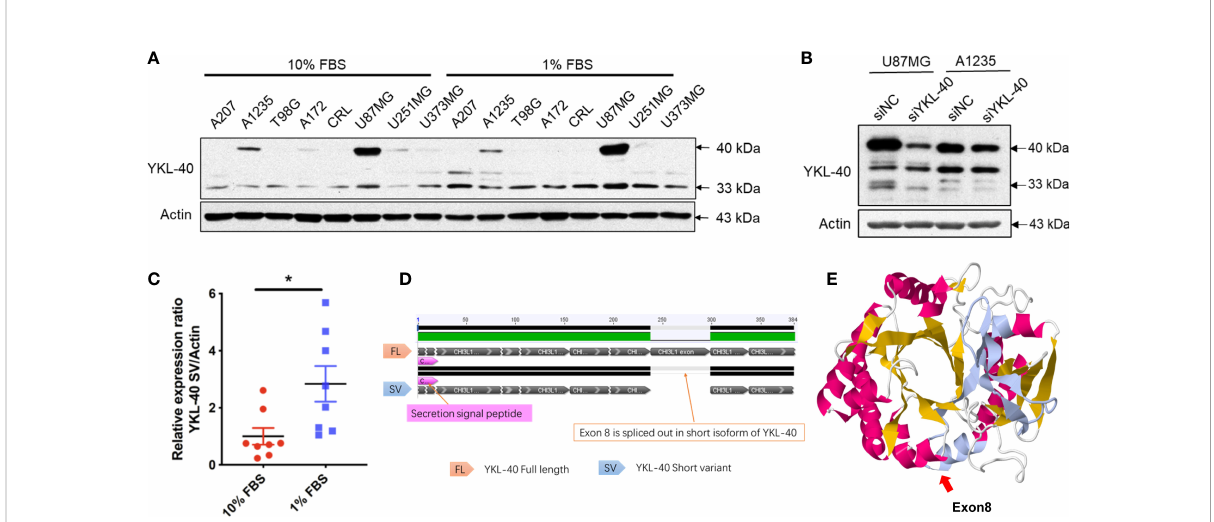
FIGURE 2 Expression patterns of YKL-40 isoforms in GBM cell lines. (A) Eight GBM cell lines cultured in full serum DMEM (10% FBS) or reduced serum DMEM (1% FBS) were lysed with RIPA buffer, and the expression levels of YKL-40 were determined by Western blot analysis. (B) U87MG and A1235 cells transfected with either siYKL-40 or siNC were lysed with RIPA buffer, and the expression levels of YKL-40 were determined by Western blot analysis. (C) The expression of the YKL-40 short isoform was signi fi cantly upregulated after low-serum treatment (Bars, SEM. Student ’ s paired t -test. * p < 0.05, n = 8). (D) Pairwise alignment of the cDNA sequences of the two isoforms of YKL-40. (E) Stereo view of the YKL-40 protein structure. The structure of exon 8 is indicated in